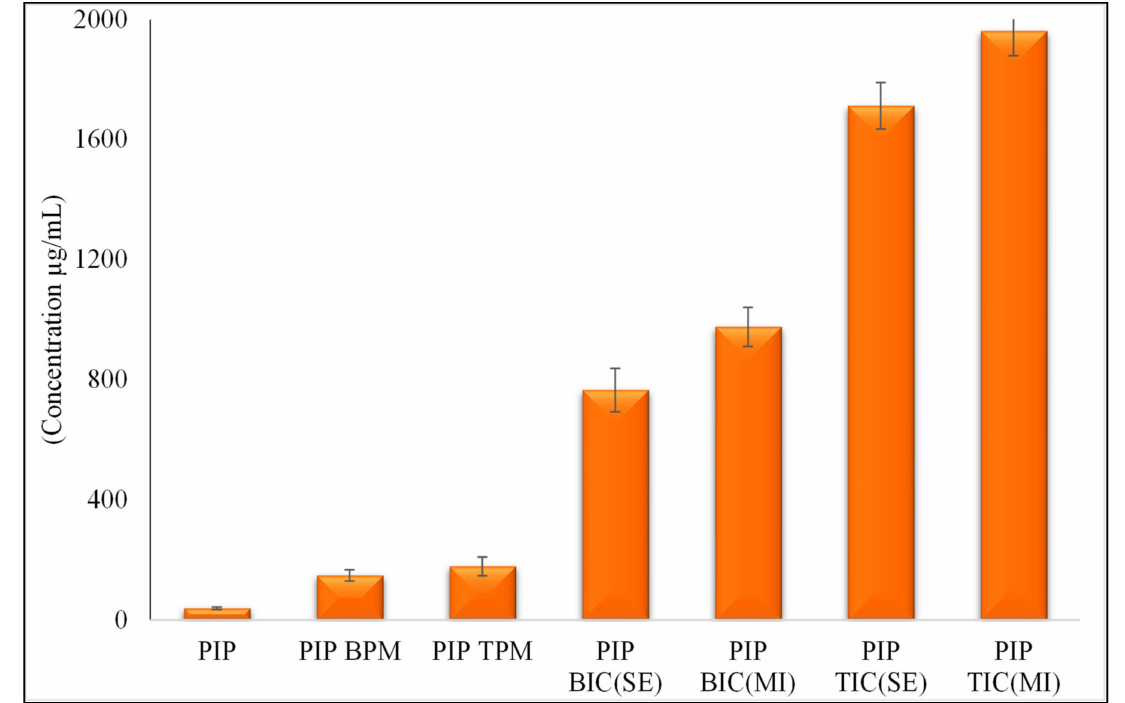
Figure 3. Comparative saturation solubility study of pure PIP and PIP binary and ternary inclusion complex. Values are presented as means ± SD with